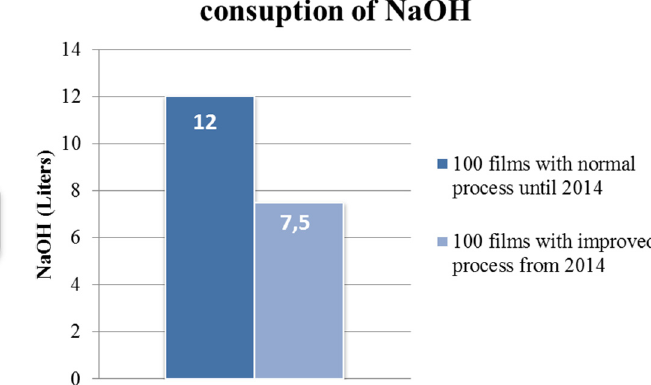
Fig. 5. Standard organization model for dissemination used by ISS. Fig. 6. Average consumption of NaOH used for the development of 100 LR115